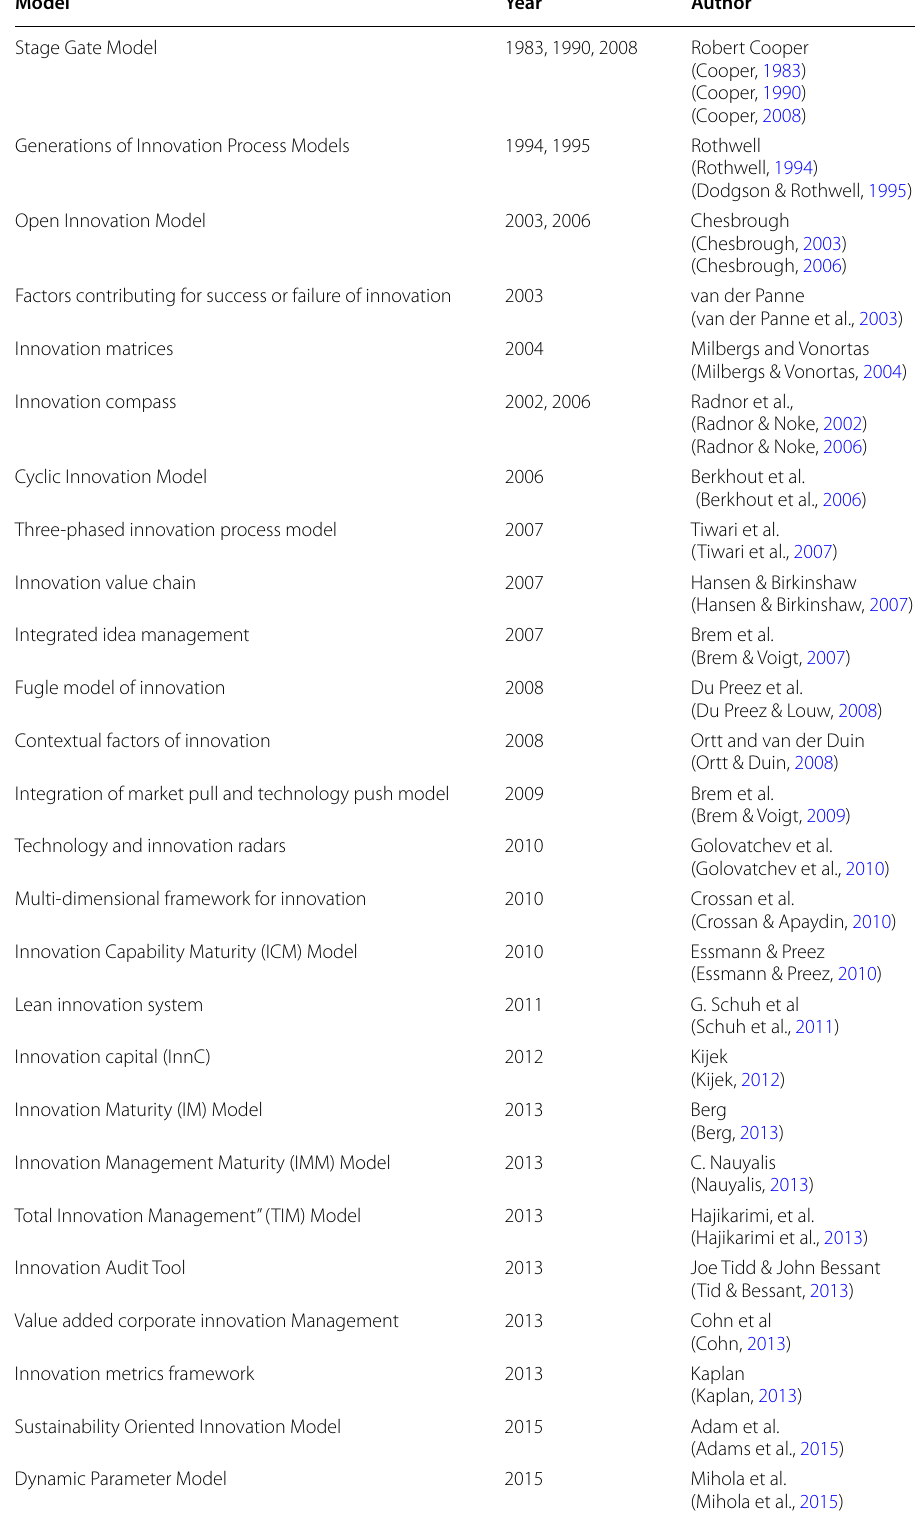
Table 2 Innovation